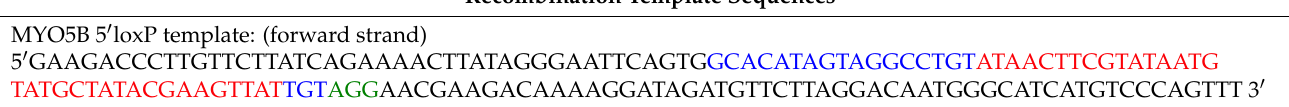
Table 1. Primers used in genotyping protocols. Recombination Template